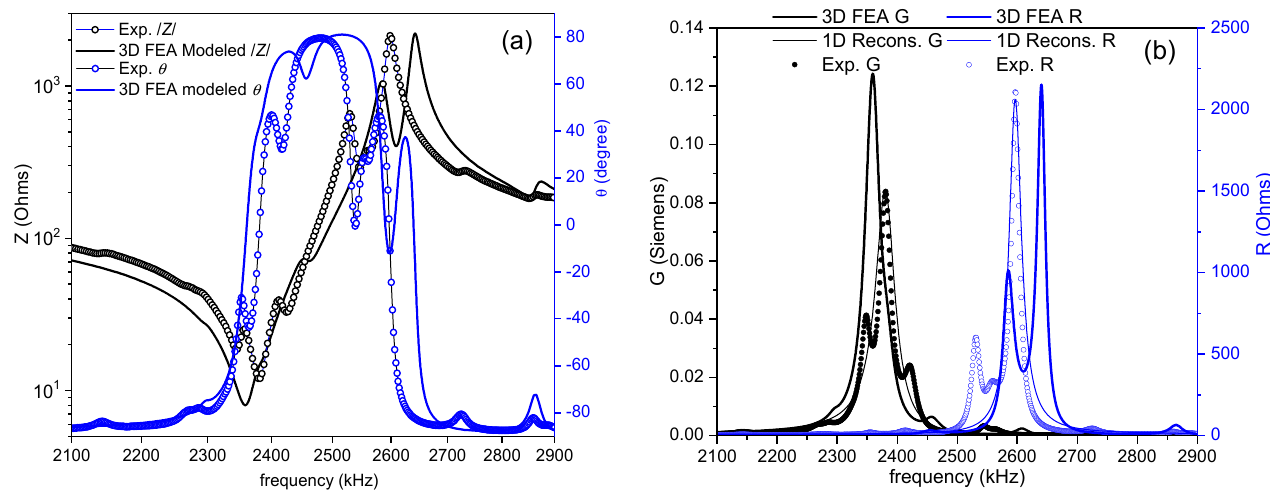
Figure 6. Fundamental radial extensional resonance mode of a thickness-poled and excited thin disk. The FEA-modeled (thick lines) impedance spectrum in an ( R , G ) plot of a disk with a diameter of 12 mm and a thickness of 1.15 mm. The experimental data (symbols) and the reconstructed spectrum after the calculation of the parameters in a 1D model (thin lines) are also shown for com- parison. Black symbols and lines (G data) can be read in the left-y-axis, and the blue ones ( R data) are in the right-y-axis.